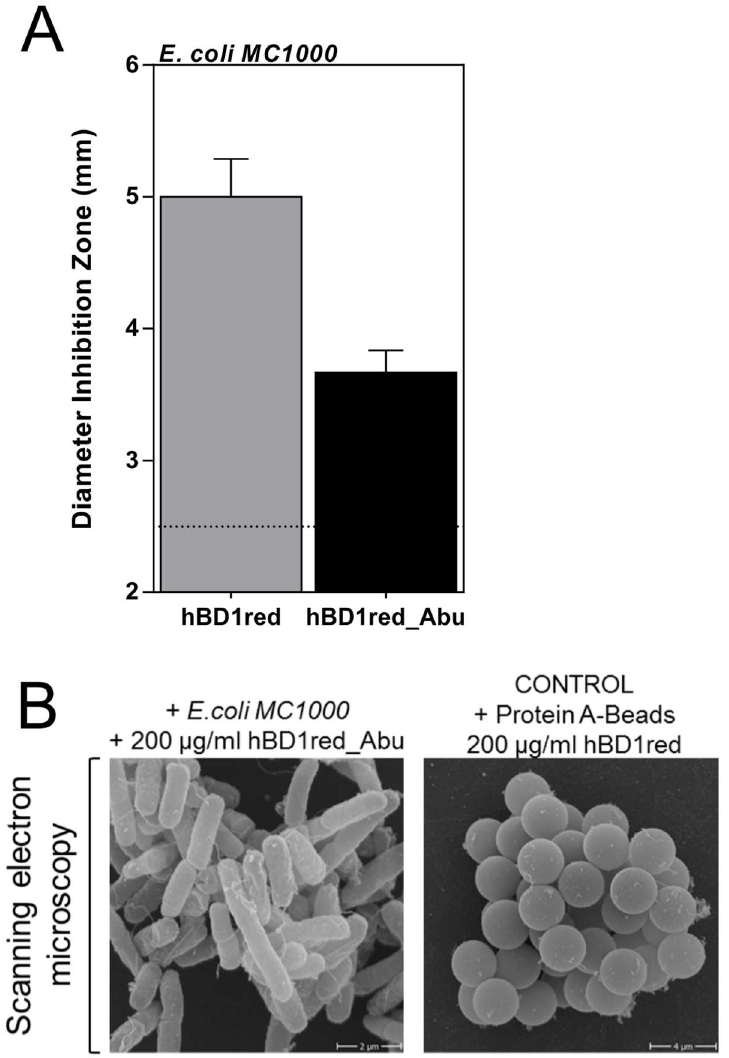
Fig 4. Net-formation of hBD1red depends on free cysteines. (A) 2 μ g of hBD1red and hBD1red_Abu, a variant in which cysteine is replacedby α -amino-butyric acid (Abu), were tested in a RDA Assay against E .